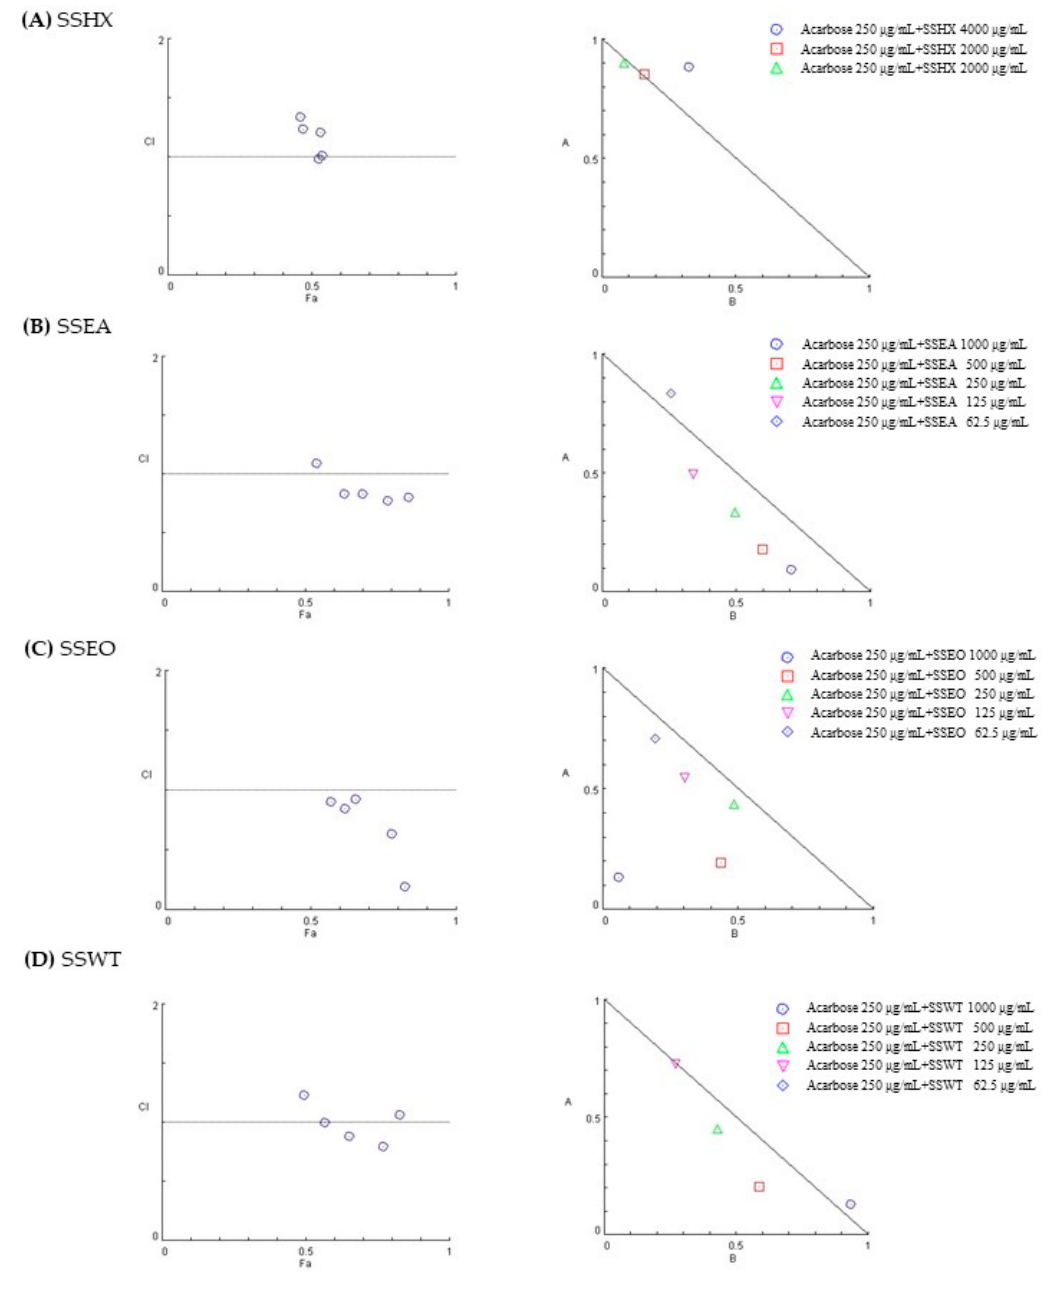
Figure 1. Fa-CI plots of SSHX, SSEA, SSEO, and SSWT, respectively ( A – D ). The normalized isobolo- grams of each extract are on the